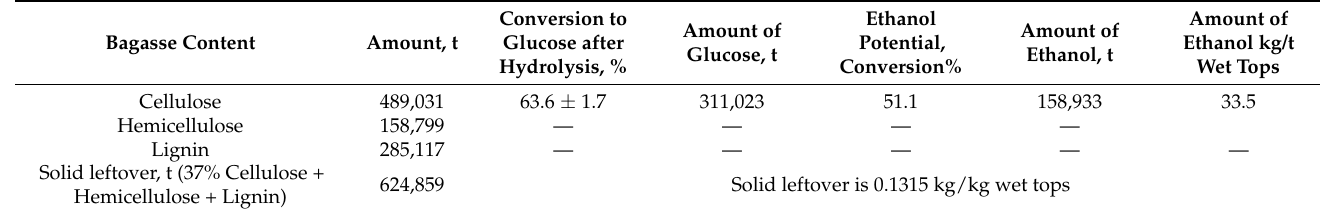
Table 13. Potential of ethanol production from trash/tops.